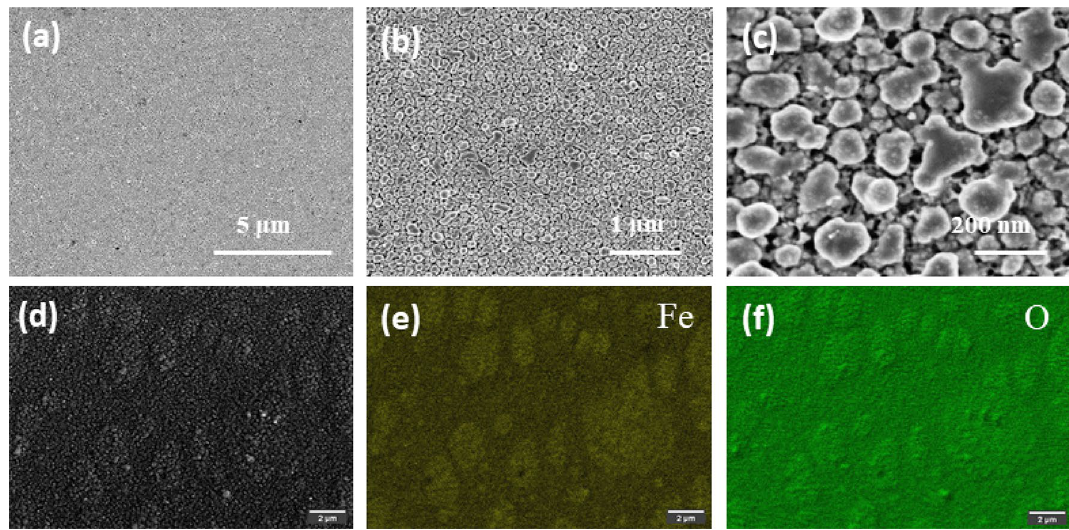
Figure 3. ( a – c ) SEM images of α-Fe 2 O 3 with different magnifications, ( d – f ) SEM image ( d ) and EDS maps of Fe ( e ) and O ( f